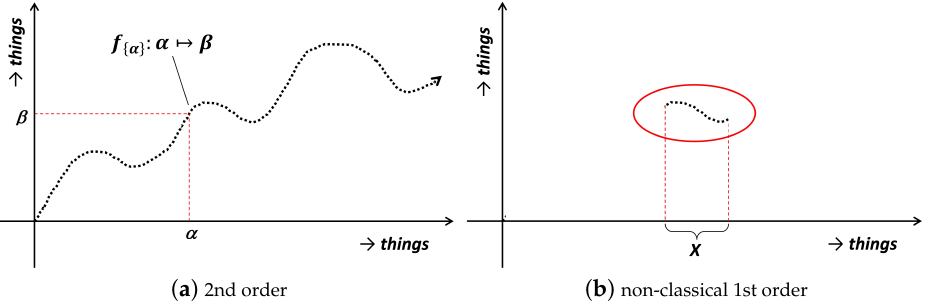
Figure 2. Illustration of the heuristic argument. In both diagrams ( a , b ), all things in the universe of T are for illustrative purposes represented on the horizontal and vertical axes. In diagram ( a ), the dotted black line represents an arbitrary functional relation ˆ Φ : each dot corresponds to a constant ur-function as indicated, so the dotted line is equivalent to a proper class of ur-functions. In diagram ( b ) it is indicated of which things on the horizontal axis the set ˆ X is made up, and each of the black dots within the red oval corresponds to a constant ur-functions: the dotted line segment is thus equivalent to a set of ur-functions. So, a multiple quantifier ( quantifier Φ . ∀